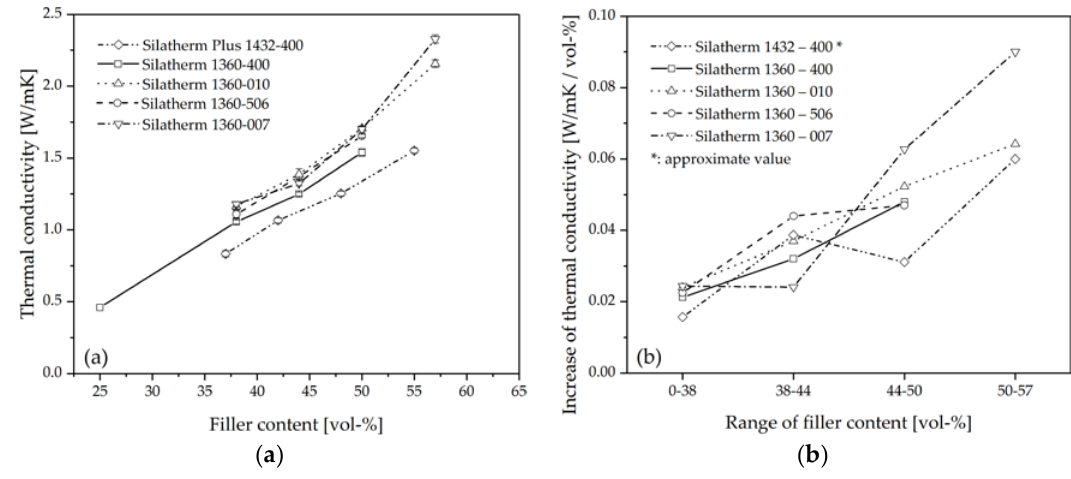
Figure 6. ( a ) Measured thermal conductivity of composites with different filler and filler content; ( b ) Increase of thermal conductivity with 1 vol % more filler in different filler content range.